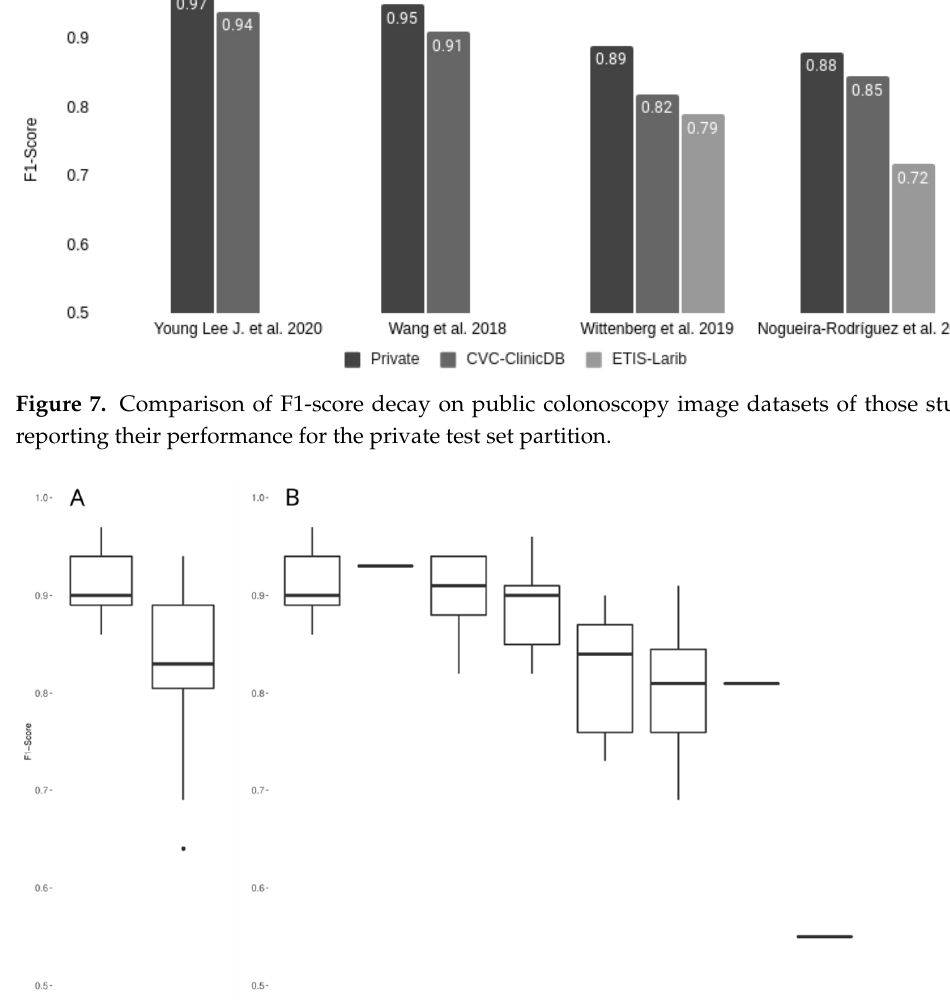
Figure 8. ( A ) Comparison of intra-dataset and inter-dataset performances of the 20 selected studies. ( B ) Same as A, with the inter-dataset performances disaggregated by dataset.